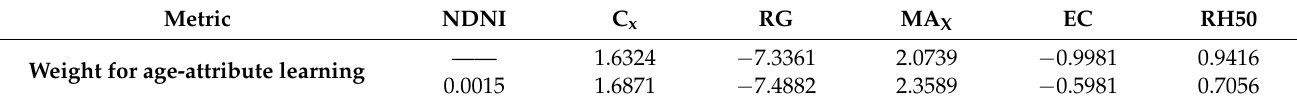
Table 5. Importance of metrics in the age-attribute ranking function of the two best learning cases.